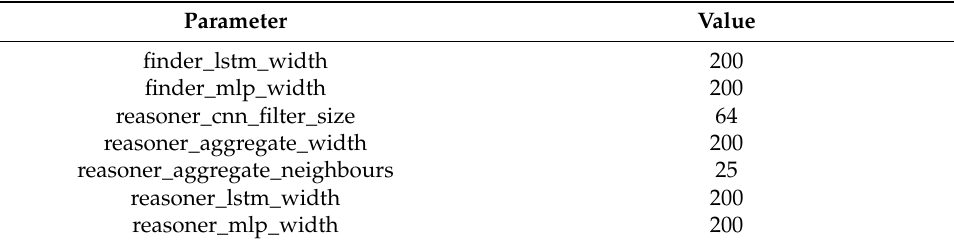
Table 2. Network